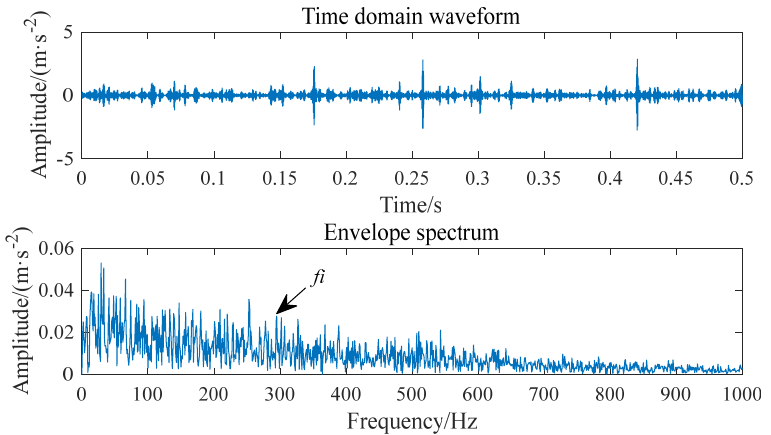
Figure 22. The reconstructed signal and its envelope spectrum obtained based on the WPT Kurtogram algorithm.